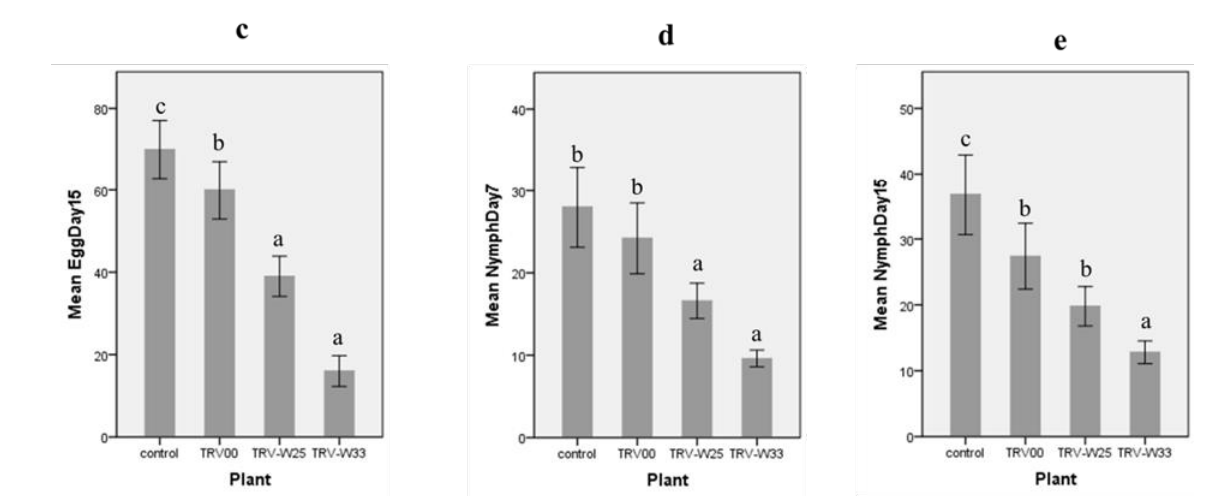
Figure 7. Whitefly bioassay on cotton VIGS-infiltrated plants. ( a ) Non-infiltrated, TRV:TRV2-WRKY33-, TRV:TRV2-WRKY25-, and TRV:00-infiltrated cotton plants under whitefly infestation. ( b ) Colored bars represent egg production at 7th day of whitefly infestation. Error bars show standard error within the replicates. Specific letters are assigned to bars according to a standard error within replicates, with a 95% level of the confidence interval and a t value of 9.235. ( c ) Colored bars represent egg production at 15 days of whitefly infestation. Error bars show standard error within the replicates. Specific letters are assigned to bars according to a standard error within replicates, with a 95% level of the confidence interval and a t value of 9.352 ( d ) Colored bars represent nymph production at 7th day of whitefly infestation. Error bars show standard error within the replicates. Specific letters are assigned to bars according to a standard error within replicates, with a 95% level of the confidence interval and a t value of 10.829 ( e ) Colored bars represent nymph production at 15th day of whitefly infestation. Error bars show standard error within the replicates. Specific letters are assigned to bars according to a standard error within replicates, with a 95% level of the confidence interval and a t value of 10.647.